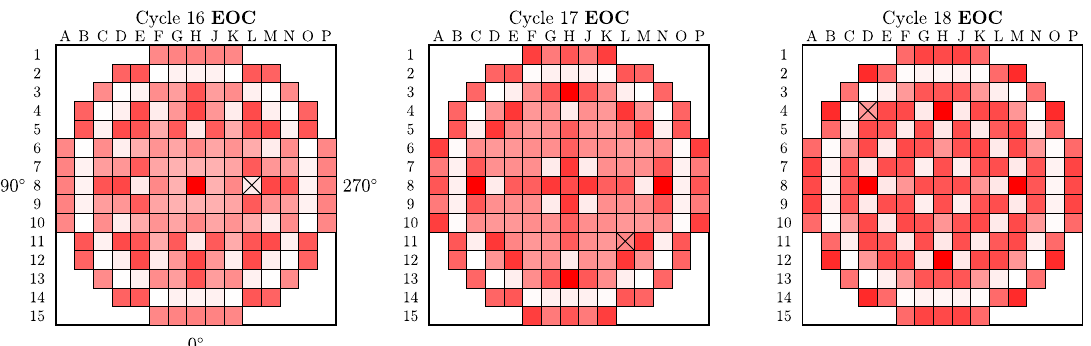
Fig. 2. Locations of the assemblies 16-01 (cycles 16 and 17) and 17-01 (cycle 18) containing the GU3 sample. The positions of both assemblies are indicated by a cross. The colors are proportional to the assembly burnup obtained from SIMULATE-3 at the end of each cycle